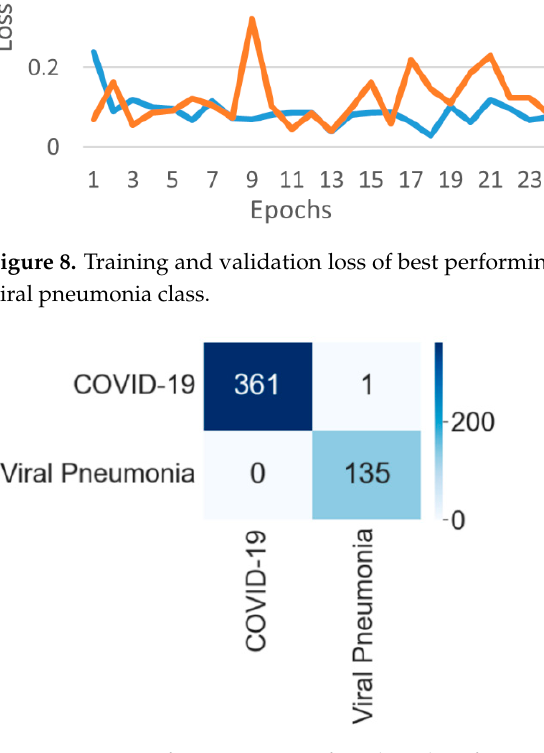
Figure 9. Confusion matrix for the classification into COVID-19 and viral pneumonia by NasnetMo- bile.